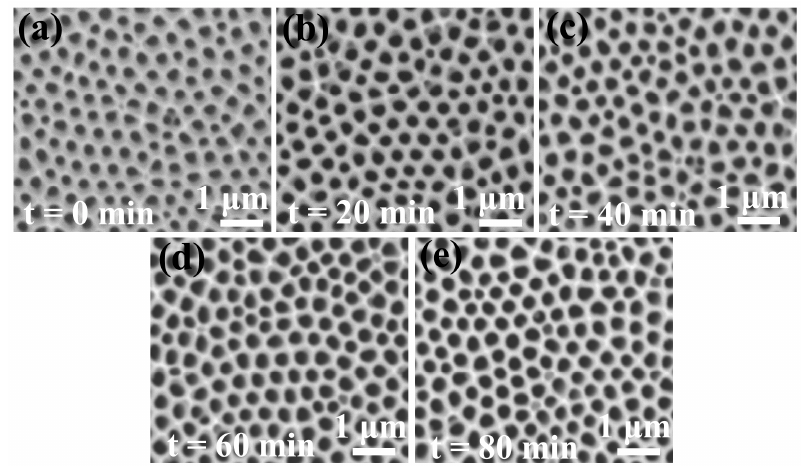
Figure 8. SEM images of the AAO template after etching for different times: ( a ) 0 min; ( b ) 20 min; ( c ) 40 min; ( d ) 60 min; and ( e ) 80 min.